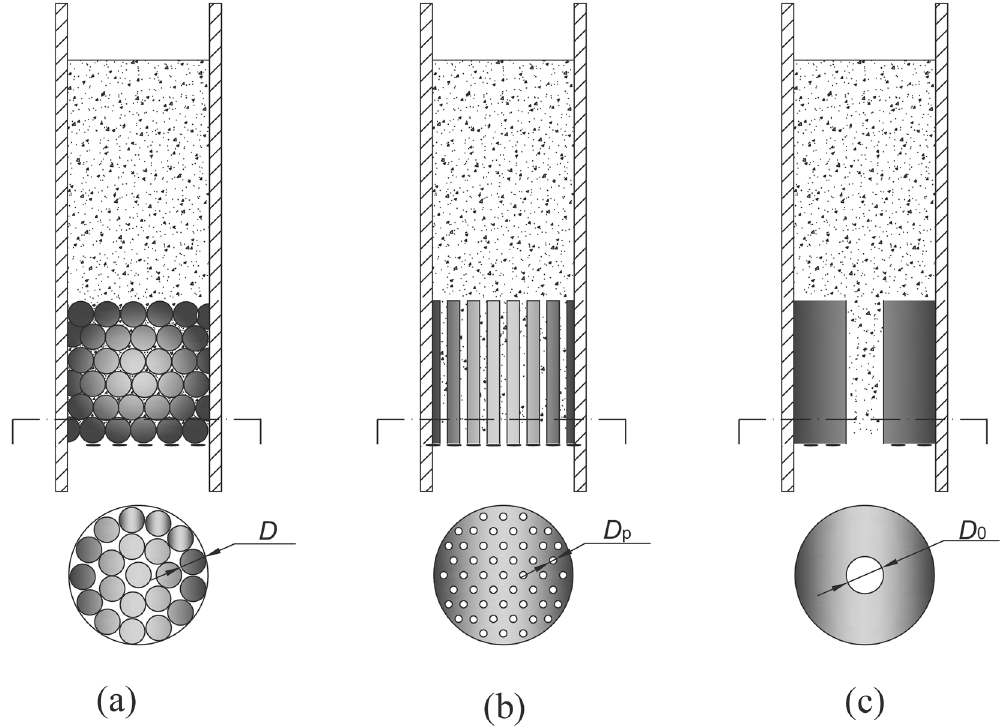
Figure 4. Schematic representation of sand flow through ( a ) porous bed; ( b ) multiple orifices; ( c ) one